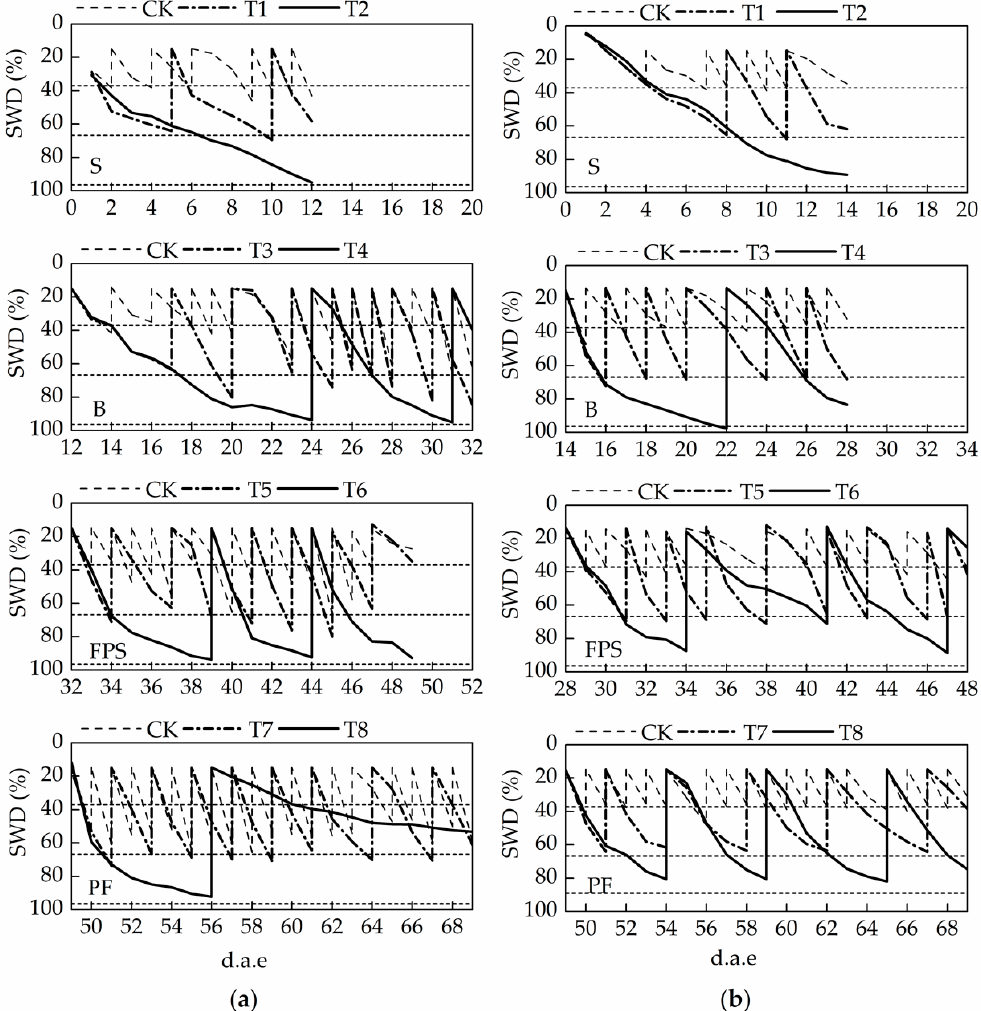
Figure 5. Soil water deficit for each irrigation treatment (full irrigation, mild and severe water stress) during different growth stages in: 2015 ( a ); and 2016 ( b ). S, seedling stage; B, branching stage; FPS, flowering and pod-setting stage; PF, pod-filling stage; d.a.e, day after emergence. Horizontal dashed lines represent the SWD values corresponding to the minimum thresholds of soil water content in the CK, mild and severe drought treatments.